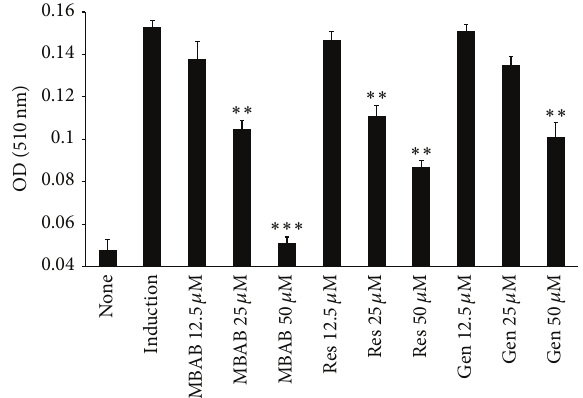
Figure 3: Inhibitory effects on 3T3-L1 adipocyte differentiation. Induction: hormone mixture, MBAB: hormone mixture + MBAB, Res: hormone mixture + resveratrol, and Gen: hormone mixture + genistein. Three independent experiments were conducted. The results are expressed as the mean ± SD of absorbance at 510 nm. ∗∗ 𝑃 < 0.01 and ∗∗∗ 𝑃 < 0.001 represent significant differences when comparing the hormone treatment group (induction